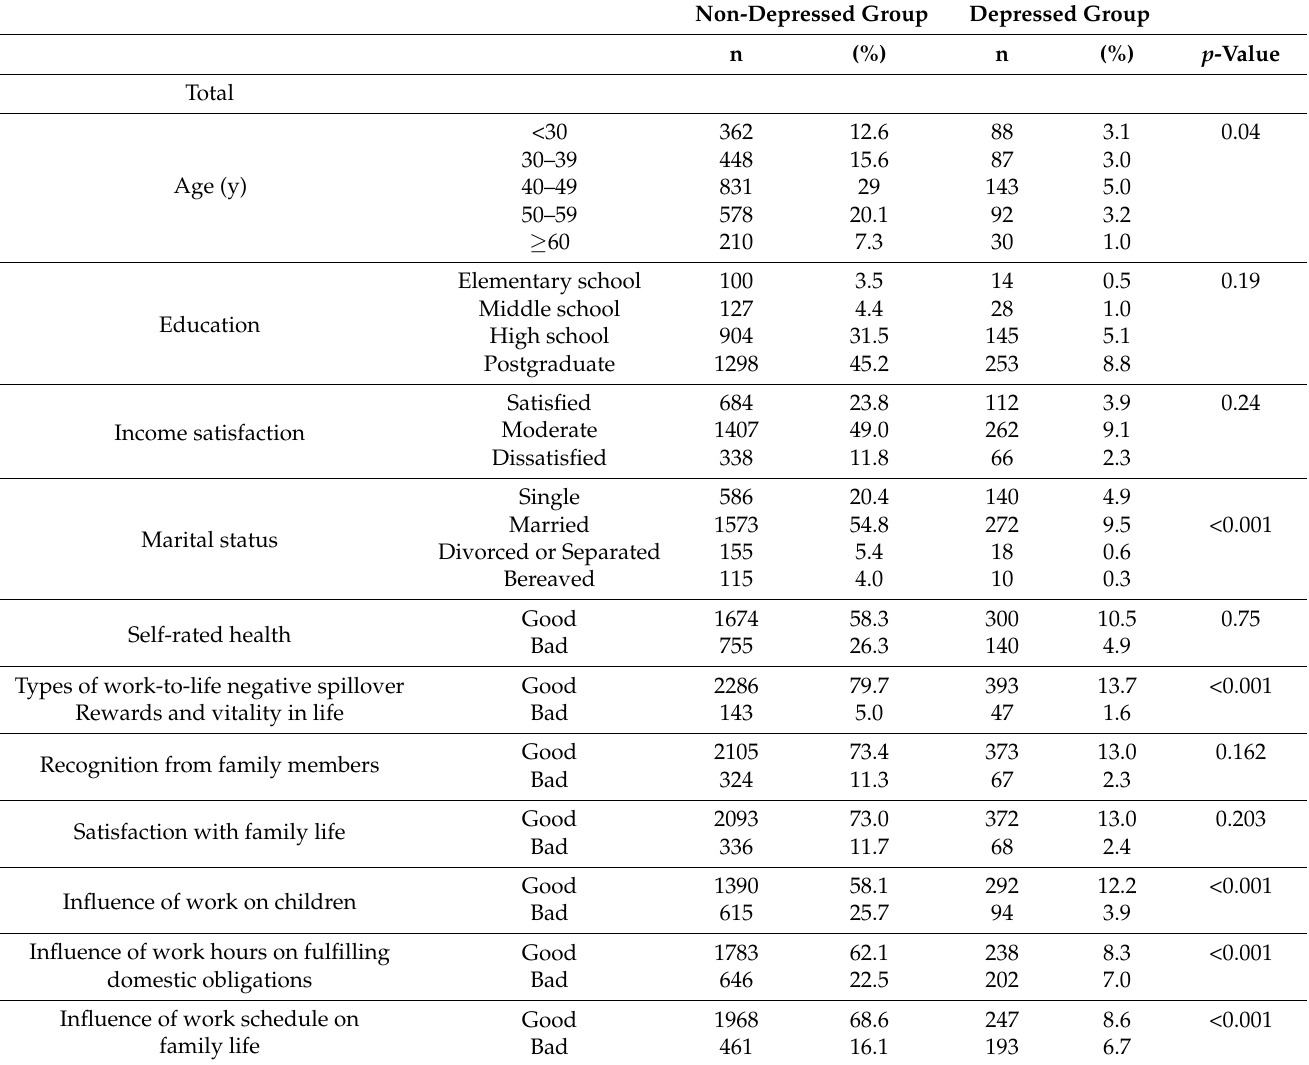
Table 2. Association between work-to-life spillover and depressive